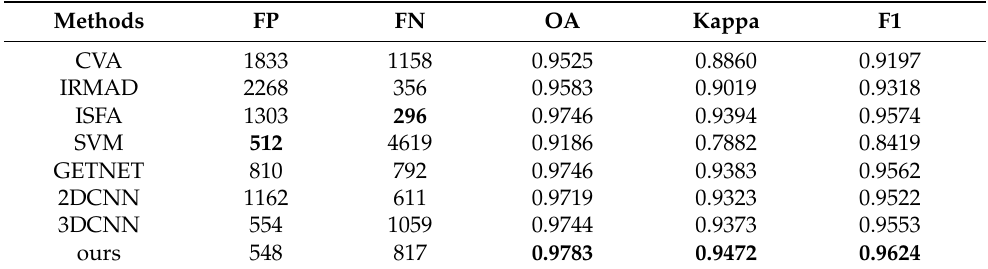
Figure 8. The change map on Yancheng dataset. ( a ) CVA. ( b ) IRMAD. ( c ) ISFA. ( d ) SVM. ( e ) GETNET. ( f ) 2DCNN. ( g ) 3DCNN. ( h ) ours. Table 3. Quantitative evaluation of CD results by different methods for Yancheng